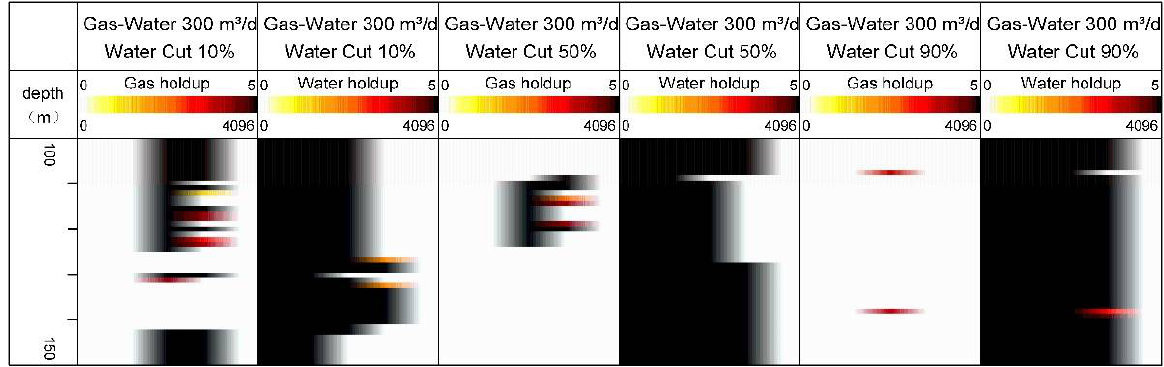
Figure 5. Response characteristics when water cut of 300 m 3 /d of gas and water is 10%, 50%, and 90%.